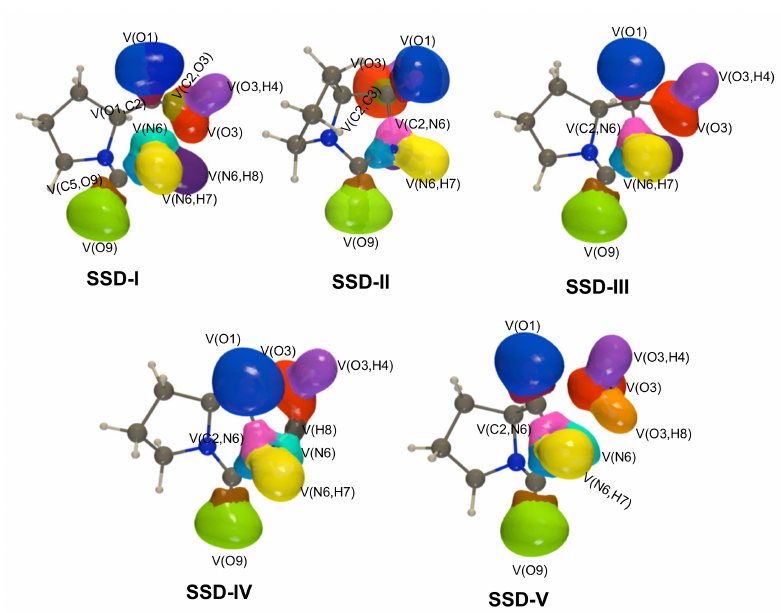
Figure 10. ELF basin isosurfaces ( η = 0.7) of each of the SSDs found along the IRC associated with TS4-a . Color labeling of the basins is adopted according to Figure